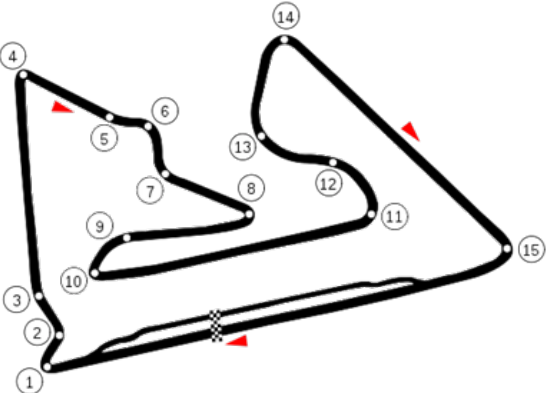
Figure 31. Map of the F1 Sakhir circuit in Bahrain, with official corner numbering.